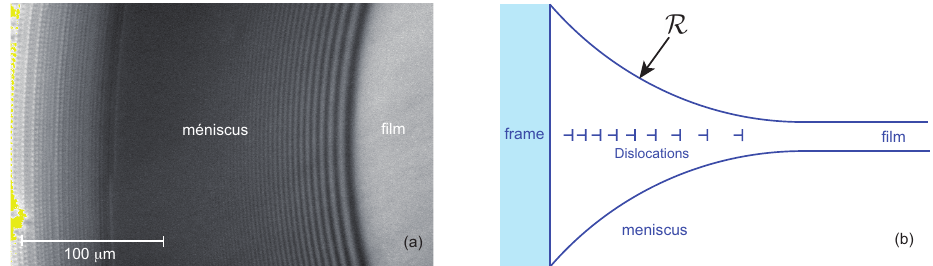
Figure 9. ( a ) typical appearance in reflecting microscopy of the meniscus formed between a film(on the right) and the frame (on the left). From the interference fringes observed in the thin region of the meniscus, the radius of curvature of the meniscus can be deduced; ( b ) model of meniscus of radius of curvature R filled with dislocations (adapted from Ref.